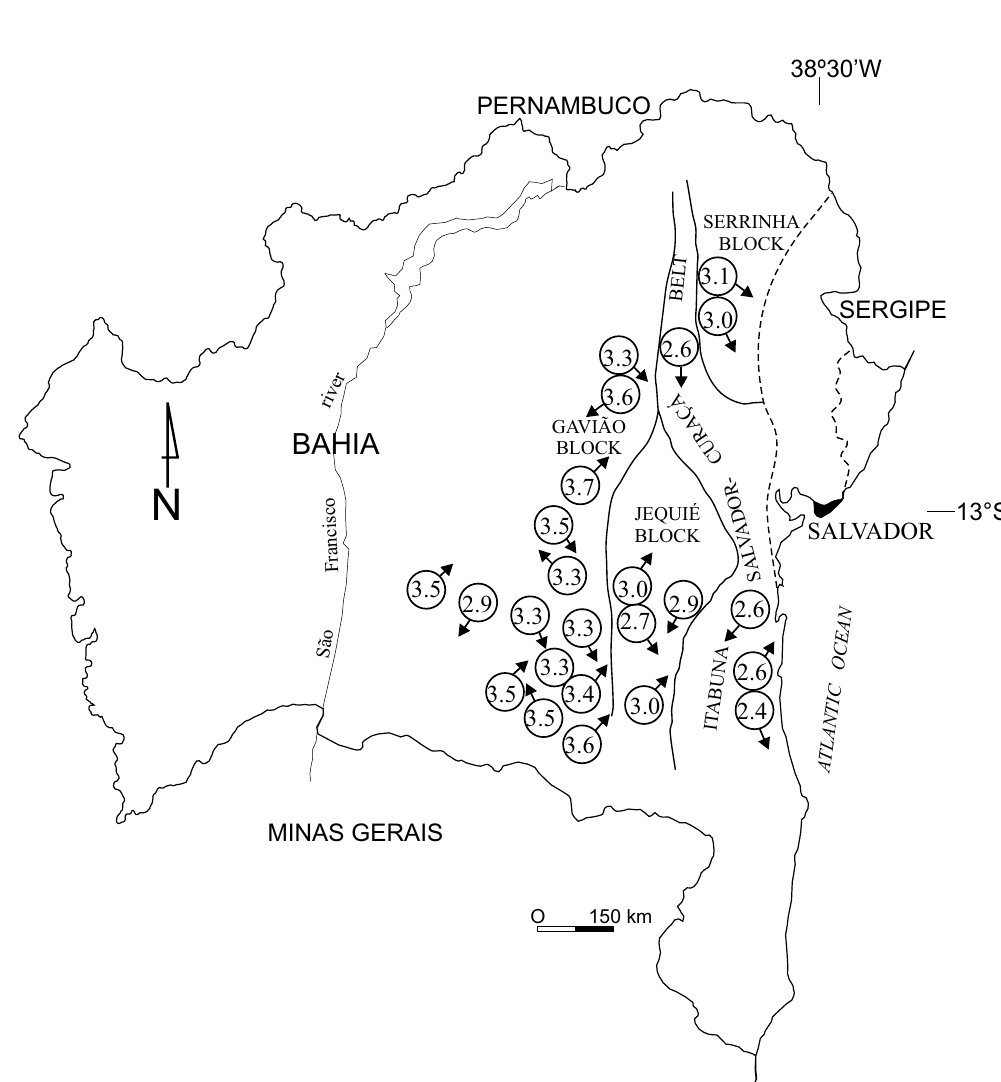
Fig. 2 – Sm-Nd (T DM ) ages (Archean and Paleoproterozoic) in Bahia State-Brazil. (Source of data, see tables I-V). In the Gavião Block (Figs. 2, 4, 5), dated by U-Pb SHRIMP on zircon, two groups of TTG rocks make up the early continental crust metamorphosed in to the amphibolite facies. The first group with age varying between 3.4-3.2 Ga (Sete Voltas/Boa Vista Mata Verde TTGs and Bernarda Tonalite, Tab. I) has been considered, through a geochemical mod- elling, to originate from the melting of tholeiitic basalts leaving as residues, garnet amphibolites or eclogites. The second group, with ages of 3.2-3.1 Ga. (Serra do Eixo/Mariana/Piripá Granitoids, Tab.